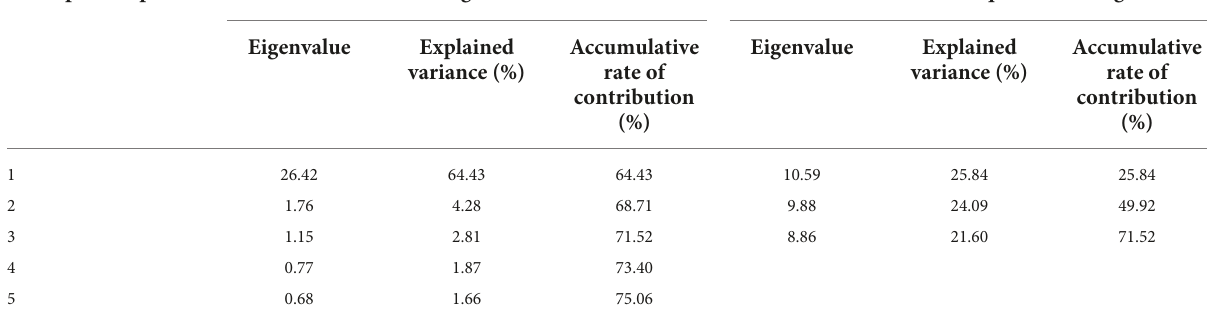
TABLE 3 Eigenvalue and accumulative rate of factor analysis. Principal